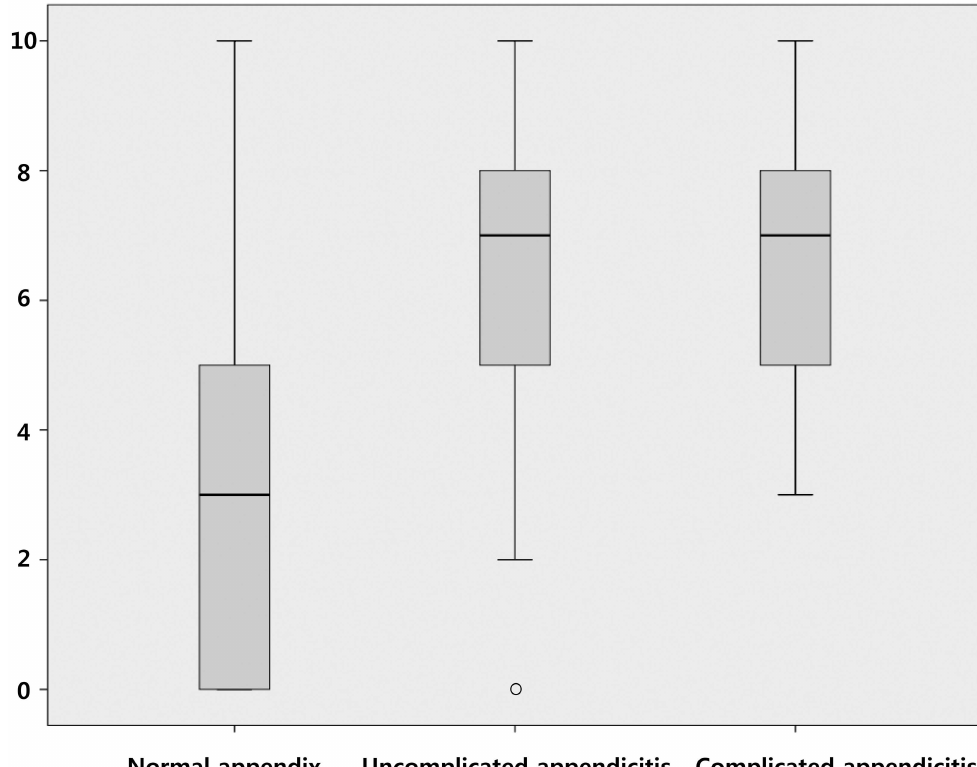
Fig 2. Box plot displaying the distribution of the MESH score in patients with a normal appendix, uncomplicated appendicitis, and perforated appendicitis (cutoff of 5). MESH Migration, Elevated WBC, Shift to left, and Heel drop